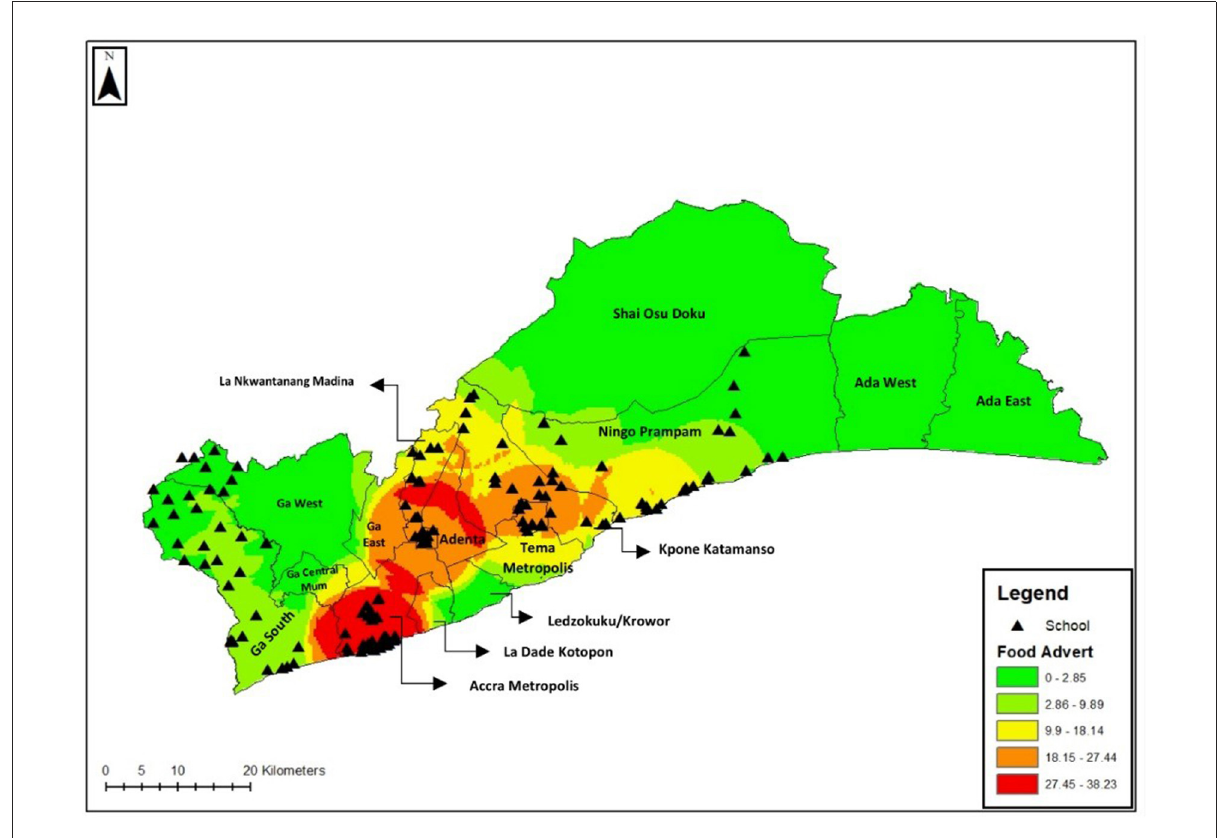
FIGURE2 Hotspot map of advertisements recorded by district.